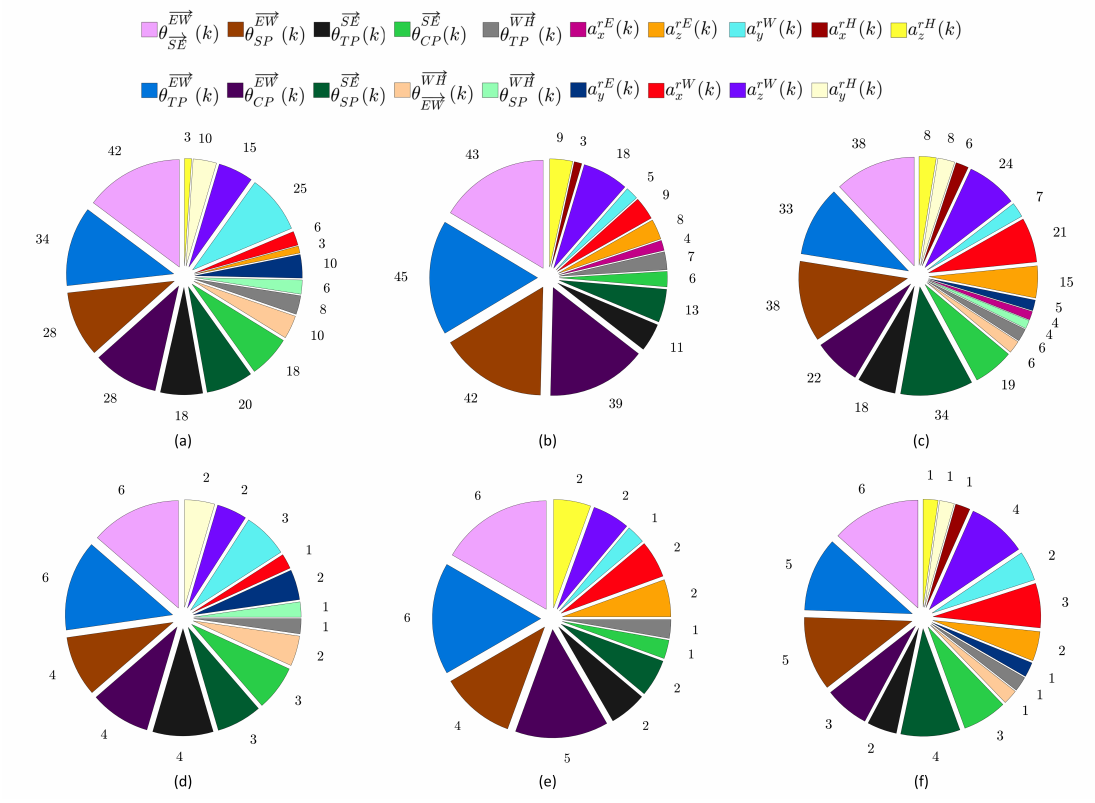
Figure 5. ( a – c ) The combination-based occurrence frequency of the features (CBOFF) values computed for the six cerebral palsy children during their participation in ( a ) the shoulder flexion, ( b ) the shoulder horizontal abduction/adduction, and ( c ) the shoulder adduction game-based exercises. ( d – f ) The participant-based occurrence frequency of the important features (PBOFIF) values computed for the six cerebral palsy children during their participation in ( d ) the shoulder flexion, ( e ) the shoulder horizontal abduction/adduction, and ( f ) the shoulder adduction game-based